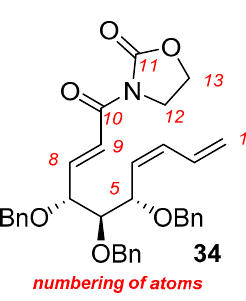
11 of 14 Figure 11. The structure of silanol 31. LR-MS: m/z = 795 [C 48 H 60 O 5 Si 2 Na (M + Na) + ]. 3.1.11. Dienoalcohol 32 This compound was prepared, analogously as 21 , from 31 . It was purified by column chromatography (hexanes → hexanes-ethyl acetate: 36:64) to give title dienalcohol 32 as a colorless oil (1.36 g, 72% over two steps) (Figure 12). Figure 12. The structure of diene 32. 1 H NMR δ : 7.37–7.22 (m, 15H, arom.), 6.58 (ddd, J = 16.7, 11.2 and 10.1 Hz, 1H, H-2), 6.27 (t, J = 11.2 Hz, 1H, H-3), 5.53 (t, J = 10.3 Hz, 1H, H-4), 5.29 (d, J = 16.7 Hz, 1H, H-1), 5.16 (d, J = 10.2 Hz, 1H, H-1 ′ ), 4.78 (d, J = 11.4 Hz, 1H, OC H 2 Ph), 4.73 (d, J = 11.4 Hz, 1H, OC H 2 Ph), 4.64–4.55 (m, 4H, H-5 and 3×OC H 2 Ph), 4.35 (d, J = 11.7 Hz, 1H, OC H 2 Ph), 3.72 (ddd, J = 11.3, 6.6 and 4.2 Hz, 1H, H-8), 3.69–3.65 (m, 2H, H-6 and H-7), 3.55 (ddd, J = 11.4, 5.6 and 3.5 Hz, 1H, H-8 ′ ), 2.12 (t, J = 6.3 Hz, 1H, OH); 13 C NMR δ : 138.6, 138.4 and 138.1 (quat. benzyl), 133.8 (C-3), 132.0 (C-2), 128.8 − 127.8 (arom. and C-4), 120.2 (C-1), 82.1 (C-6 or C-7), 79.7 (C-6 or C-7), 75.2 (O C H 2 Ph), 74.8 (C-5), 72.8 and 70.6 (2×O C H 2 Ph), 61.7 (C-8). HR-MS: m/z = 467.2180; calcd for C 29 H 32 NO 4 Na [M + Na] + : 467.2188. 3.1.12. Triene 34 Alcohol 32 (244 mg, 0.55 mmol) was oxidized as described for 22 and the resulting product was purified by column chromatography (hexanes 100% → hexanes-ethyl acetate: 1:2) to afford the